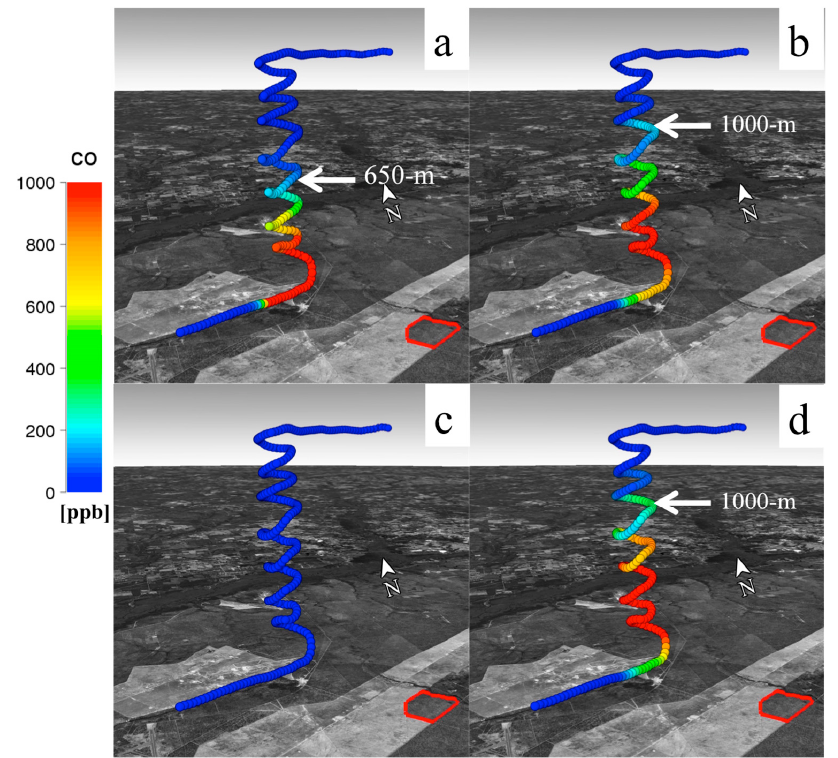
Figure 13. Same as Figure 11, but for the corkscrew vertical profile at 1830–1835 UTC. Map data: Google, DigitalGlobe.